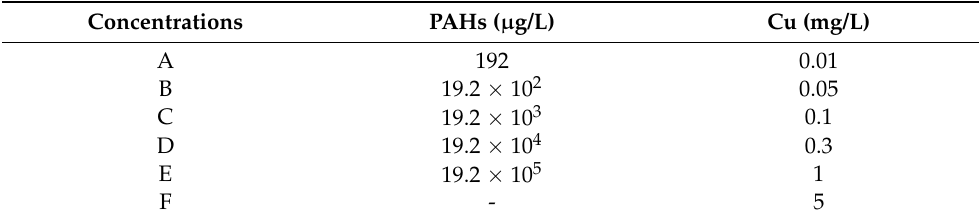
Table 1. Concentrations of PAHs ( µ g/L) and Cu ions (mg/L) to which sea urchin embryos and Botryllus schlosseri colonies were exposed. The experiments started 10 min after the fertilization of sea urchin embryos or at the introduction of B. shlosseri colonies in multi-well plates. Concentrations PAHs ( µ g/L) Cu (mg/L)